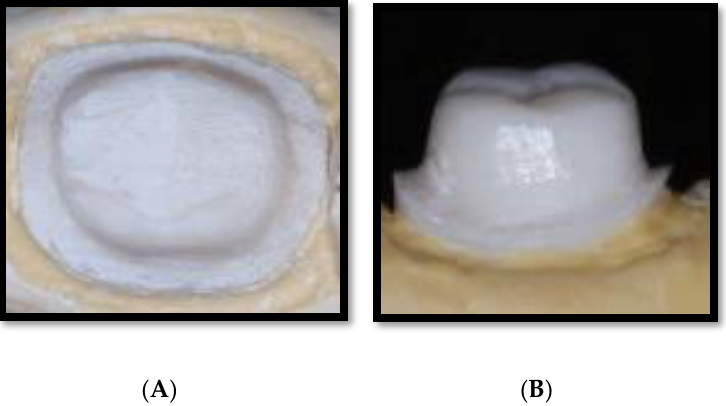
Figure 1. Representative image of the prepared tooth specimen. Prepared tooth ( A ) Occlusal, ( B ) Buccal .